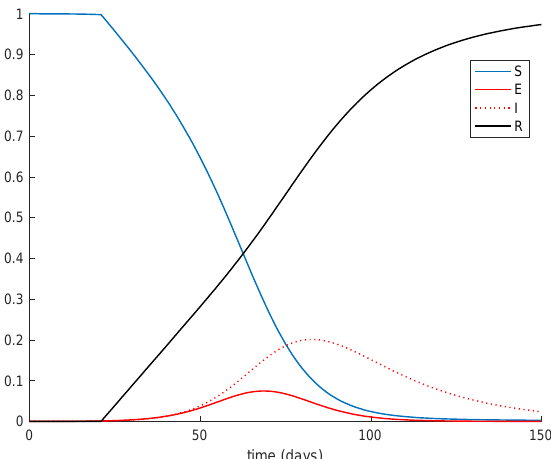
Figure 2. Dynamics of the model when two-doses vaccination is applied from the beginning.